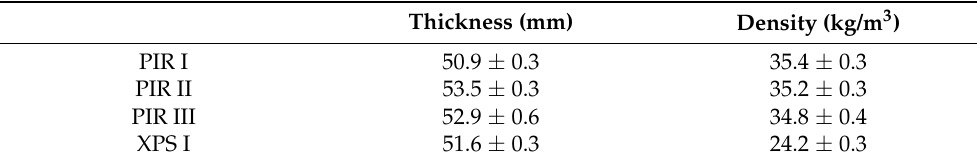
Table 1. Basic material